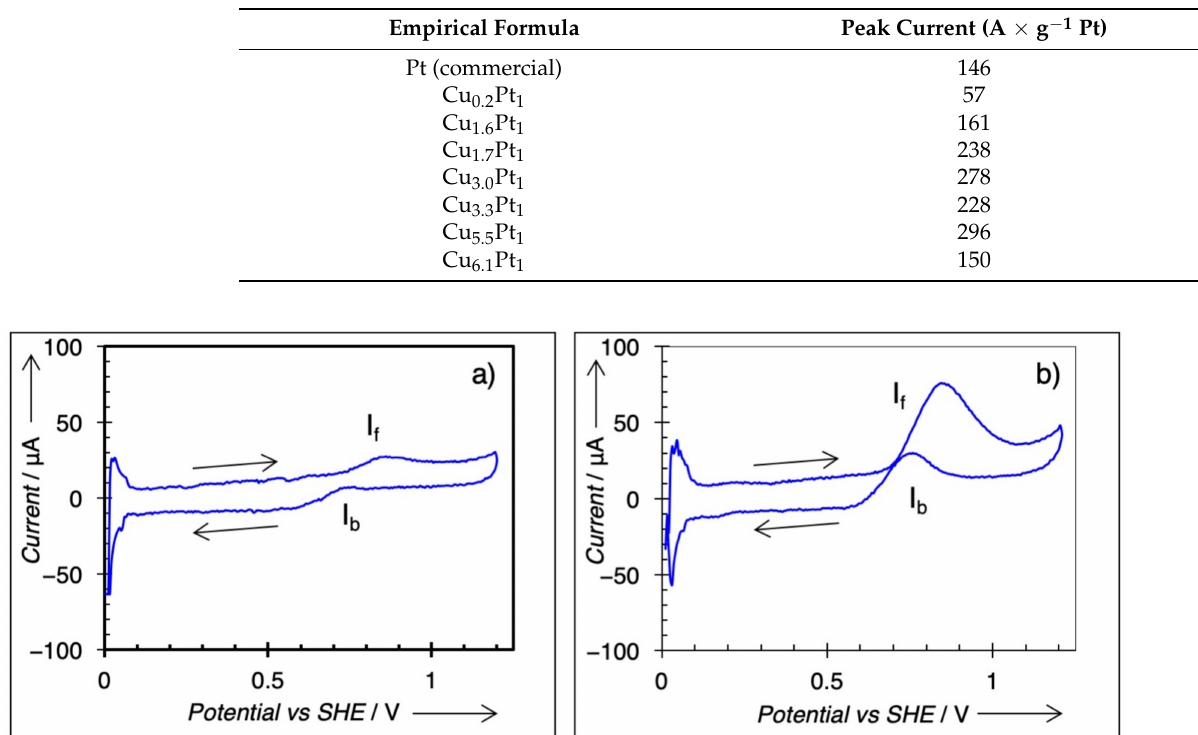
Table 2. Summary of CV results.